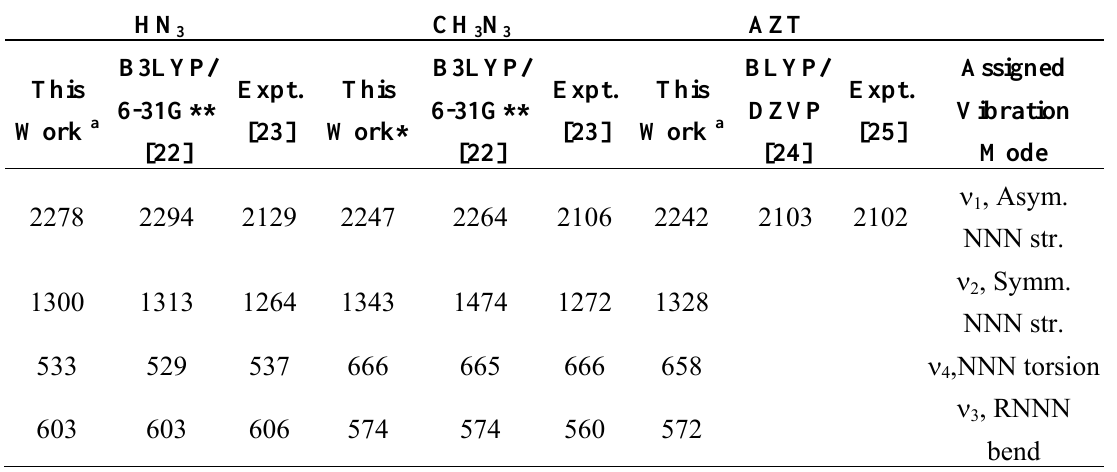
, CH3N3 and AZT (in cm -1 ). 3